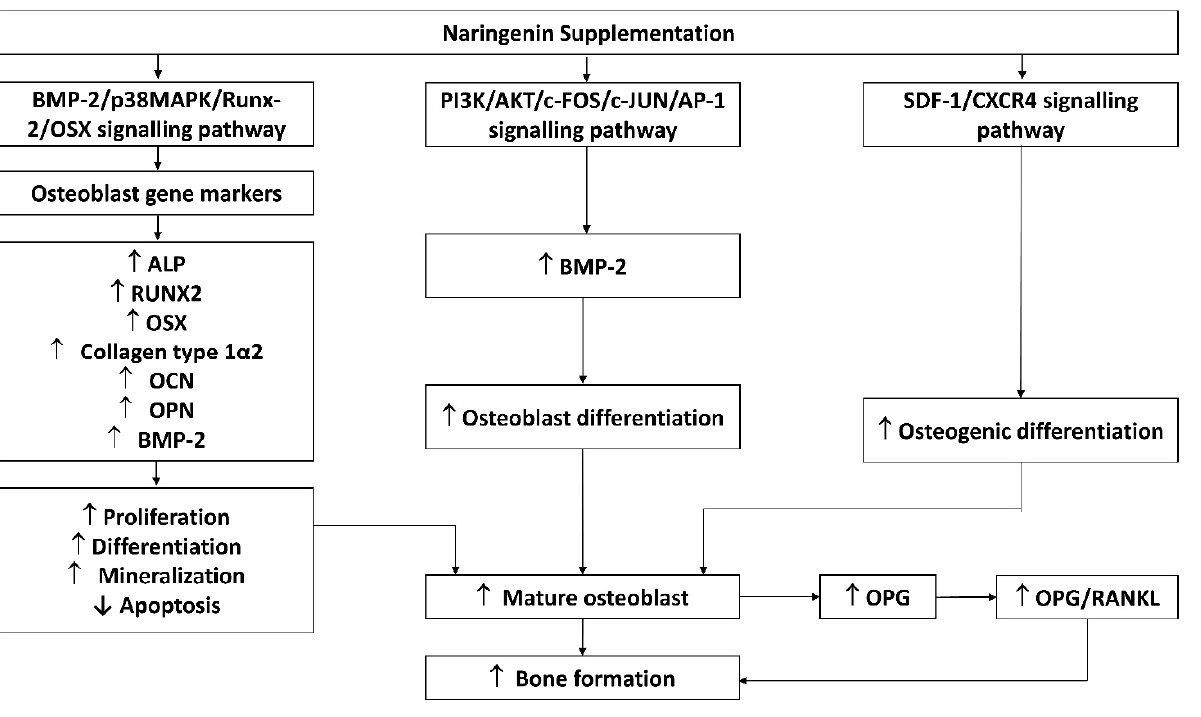
Figure 3. Possible mechanism of naringenin effect on osteoblasts. Abbreviations: ALP, alkaline phosphatase; IL-1 β , OPG, osteoprotegerin; OSX, osterix; RANK, receptor activator of nuclear factor- kappa B ligand; BMP-2; p38MAPK, phosphoinositide 38 mitogen-activated protein kinase; Runx2, runt-related transcription factor2; OCN, osteocalcin; OPN, osteopontin; P13K, phosphoinositide 3-kinase (PI3K); AKT, protein kinase B; c -FOS; c -JUN; AP-1, activator protein 1; SDF-1, stromal cell-derived factor 1; CXCR4, C-X-C chemokine receptor type 4. Osteoclasts are multinucleated hematopoietic cells that serve as the main bone-resorbing cells and play an important role in bone remodelling [36]. Naringenin significantly inhibited osteoclastogenesis and secretion of interleukin (IL)-1 α , IL-23 as well monocyte chemoattrac- tant protein-1 in pre-osteoclast cultures. A significant decrease in helical peptide 620–633 release indicating bone resorption activity by naringenin, and an increase in tumour necro-